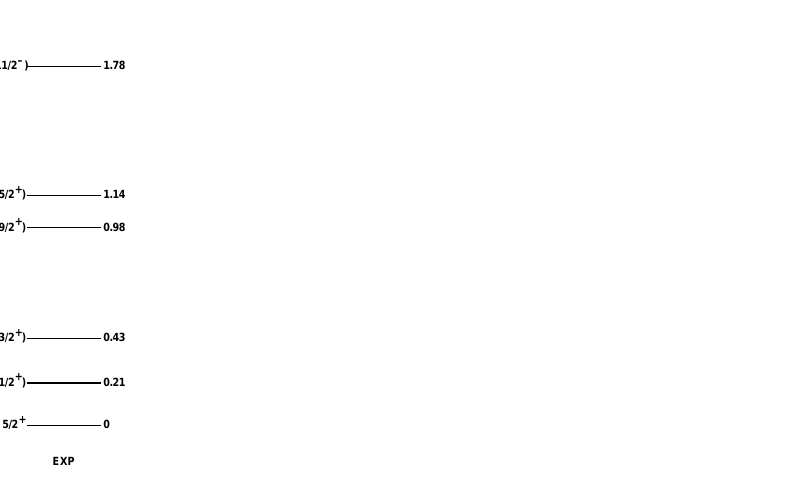
Figure 2. Theoretical low-energy spectra of 93 Sr in comparison to the experimental data from [22,29].